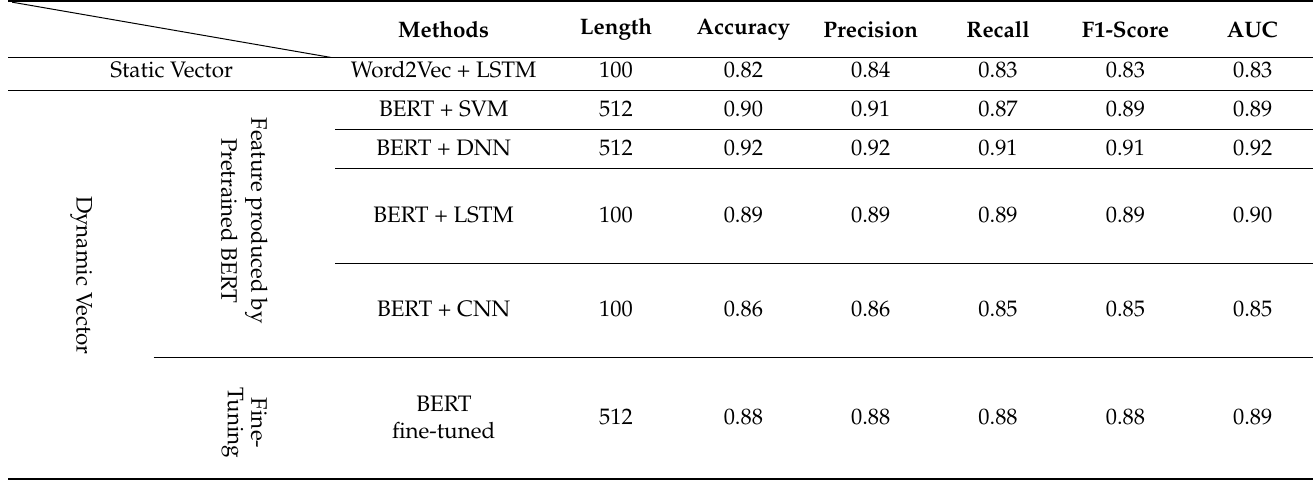
Table 6. Classification results using the Samsung